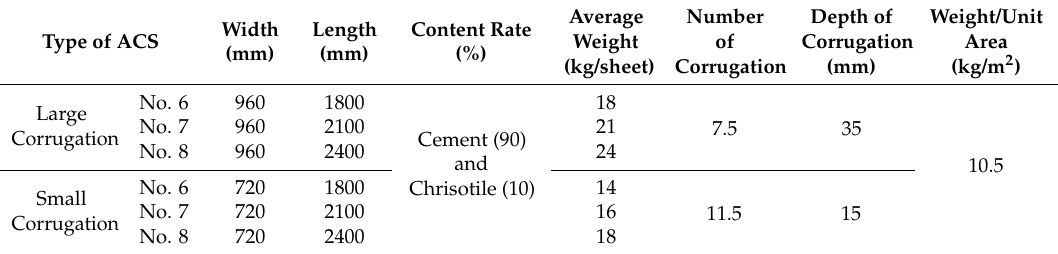
Table 1. Type and characteristics of asbestos cement slates (ACS) used in Korea building: Slates used as roofing material were produced by two enterprises and included 100% asbestos.